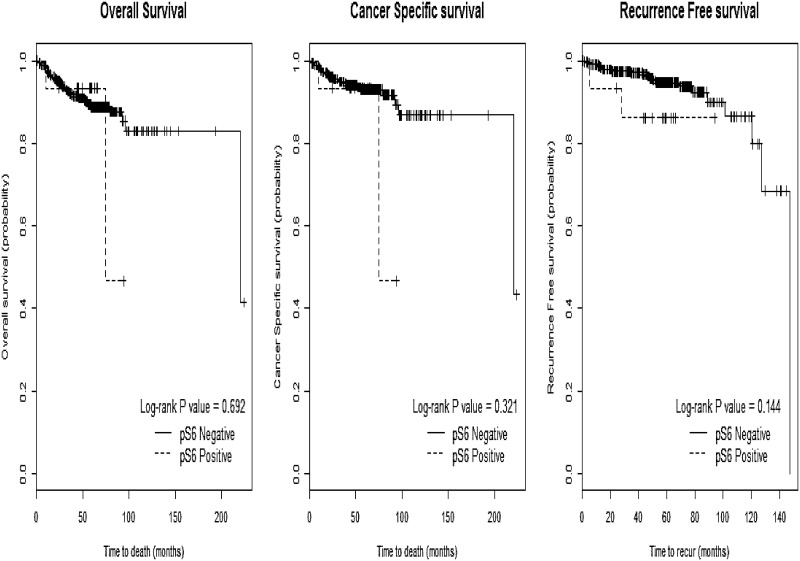
The Kaplan-Meier curves of pS6 according to (A) overall survival, (B) cancer-specific survival, and (C) recurrence-free survival.